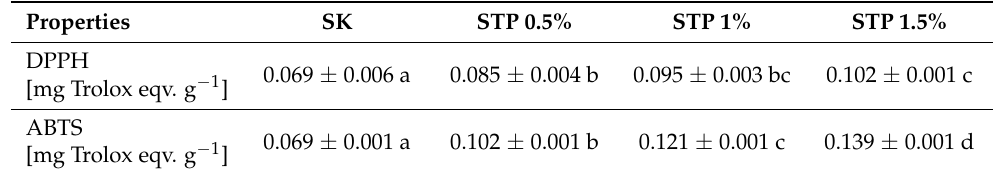
Table 8. Antioxidant activity of dry fermented